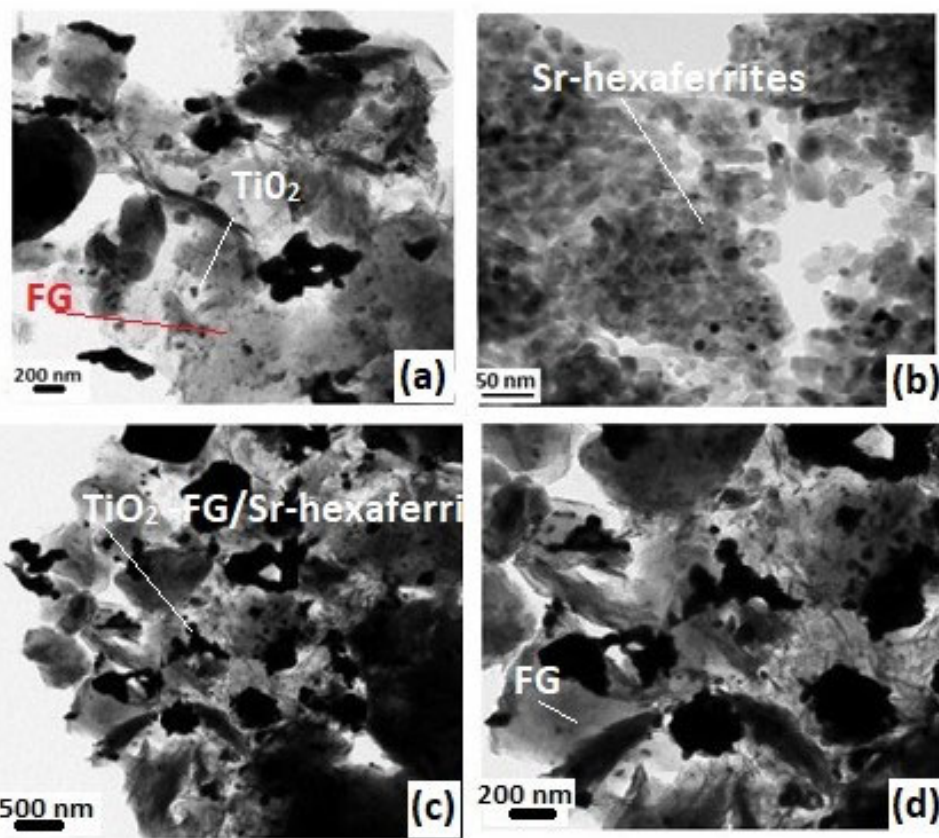
Figure 4. TEM images of ( a ) TiO 2 -FG, ( b ) Sr-hexaferrites, ( c , d ) TiO 2 -FG/Sr-hexaferrites. Figure 5 depicts the Raman bands of the FG-TiO 2 nanocomposite, which exhibit a distinct G band at 1580 cm − 1 and D band at around 1350 cm − 1 . The G and D bands in Figure 5 represent the vibration of a carbon atom at a disordered or defective site and the vibration of a carbon atom in plane, respectively, in our nanocomposites [29]. The D peak intensity is higher than that of TiO 2 -FG and TiO 2 -FG/Sr-hexaferrites, which further supports the functional density on the FG surface. There is a small 2D band observed in functionalized graphene which further confirms the layer-type morphology of FG sheets. The literature makes it abundantly evident that the D band results from the flaw caused by the functional groups on the carbon’s basal planes [30]. There are some signature peaks, such as Eg(1), B1, and g(1), found in the composite, which indicate anatase TiO 2 vibrational modes [31]. The other metallic components will have a lower intensity and cannot be seen in Raman spectra. The intensity ratio of their D to G bands can be used to determine the order of defects in FG. These results demonstrate that the addition of ternary composites changes the D band intensity, while the values of the defects may vary, and a modest increase in the band intensity is observed. There are a number of potential causes for the shifting of the Raman bands of the composite with graphene materials, including the doping of the carbon with semiconductors, the laser excitation used during Raman experiments, etc.